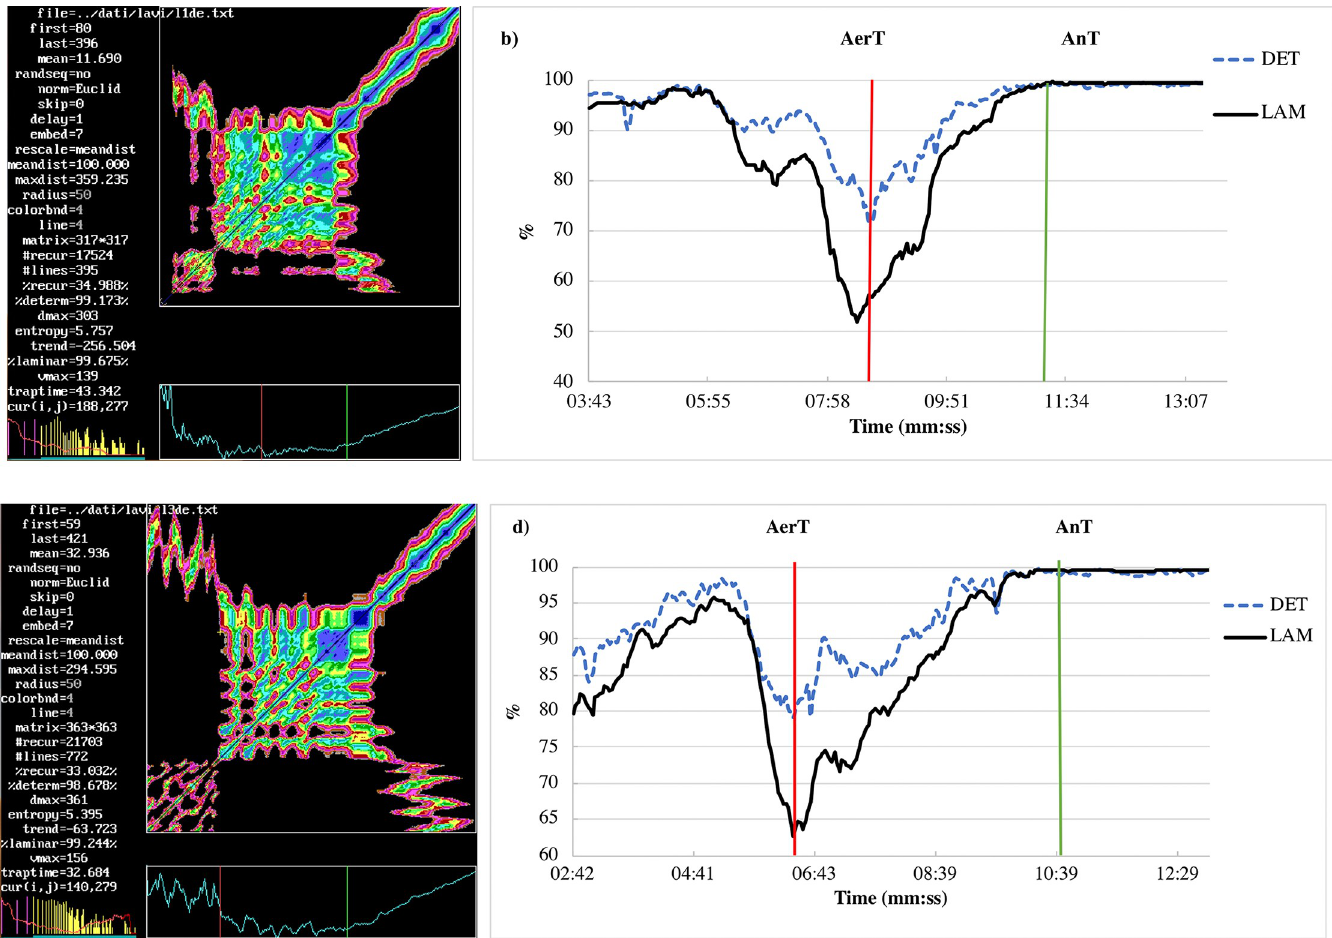
Fig 1. RP and RQE comparison. A comparison among two representative RP is shown in panel a (subject #1) and panel c (subject #3). Panel b (subject #1) and panel d (subject #3) show the percentage of recurrence points which form diagonal lines (DET) and the percentage of recurrence points which form vertical lines (LAM) epoch by epoch vs time (min:sec) of detrended RR interval. The red line enlightens the statistically relevant minimum that corresponds to the AerT and the green line corresponds to the AnT where the percent of determinism reaches saturation. Subject #1 is a competitive rower (group A, protocol 1) and subject #3 is a recreational rower (group B, protocol 2). The test starts at 00:00; AerT occurred at time T 1 , 8:38 and 5:49 for #1 and #3, respectively; AnT occurred at time T 2 , 11:24 and 11:01 for #1 and #3, respectively. A square pattern in the middle is easily distinguishable, the vertical red line is manually placed nearby before the first ventilatory transition, the green one nearby before the second one. The colors of RP reflect different Euclidean distances between trajectories and are analogous to geographical relief maps going from blue to red at increasing Euclidean distance. Distances greater than cut-off correspond to black regions. regression analysis [33]. Coefficients of determination (R 2 ) and regression parameters (slope and intercept) with the 95% of confidence intervals (95% CI) were calculated for the OLP regression equation to determine fixed and proportional biases. The hypothesis of propor- tional and fixed bias was rejected when the 95% CI contained the value 1 for the slope and the 0 for the intercept, respectively. Percentage differences between the RQA and GE methods at the AerT and the AnT (reported as mean and range values) were calculated for HR, VO and 2 Workload. RQA method validity was also assessed by comparing HR, VO and Workload at 2 the AerT and the AnT vs the same variables measured by the GE method with a paired samples t-test. Measurement error was expressed in Typical percentage Error (TE) which was calcu- ffiffiffi p lated by dividing the standard deviation of the difference percentage by 2 . Intraclass correla- tion coefficients (ICC) was used as a parameter for criterion validity of the RQA method